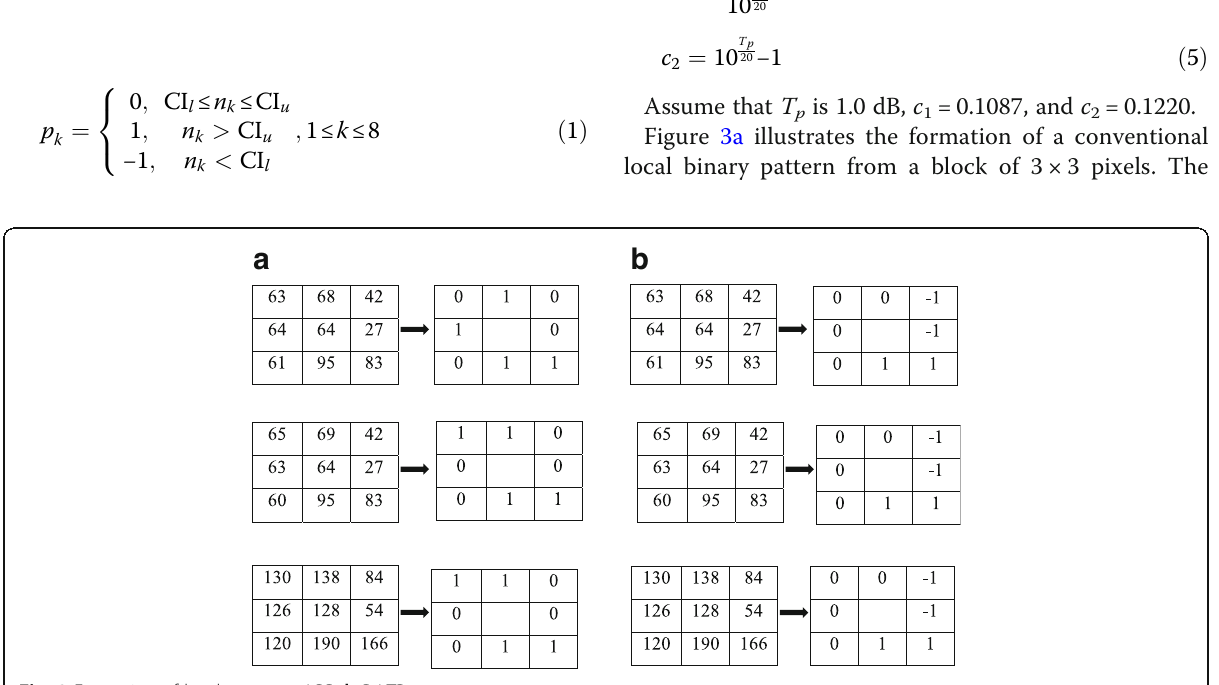
Fig. 3 Formation of local pattern a LBP. b